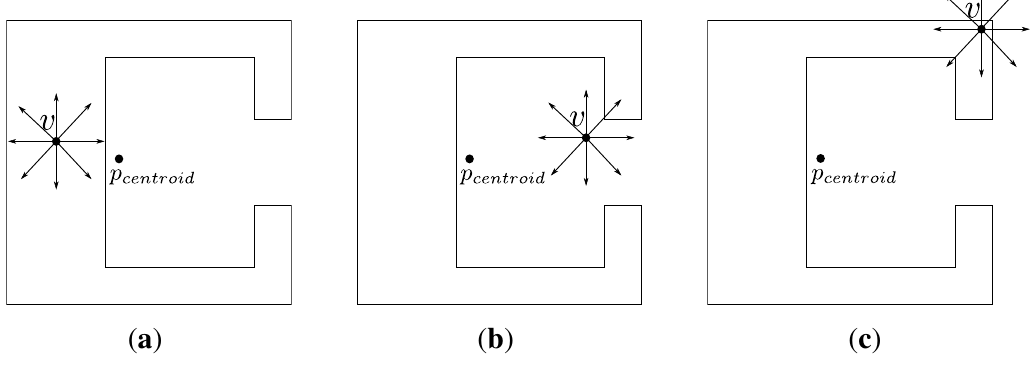
Figure 6. In each figure the set of 8 rays corresponding to a point v are represented by arrows. p represents the centroid of each centroid